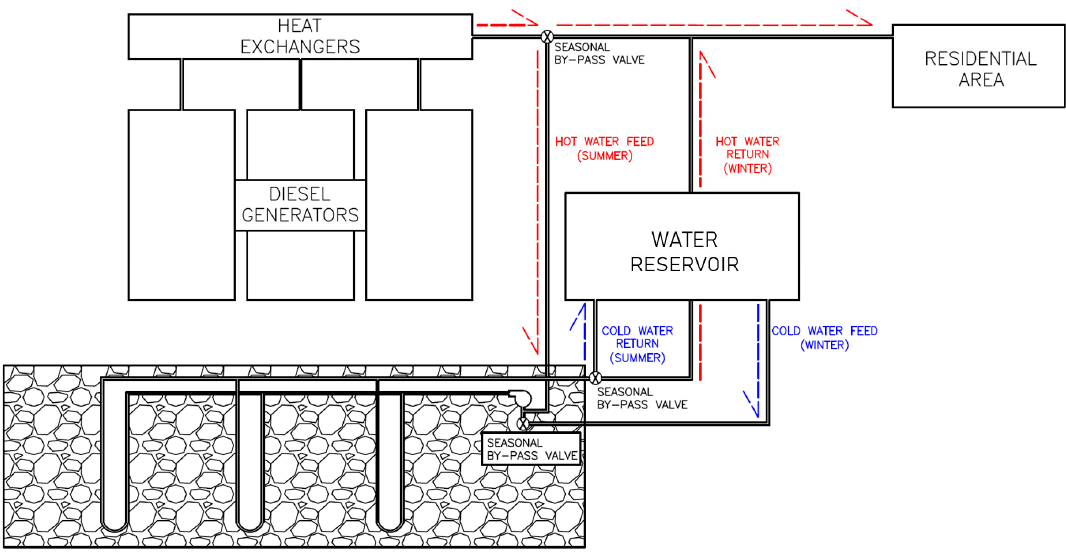
Figure 1. Schematics of heat recovery, storage, and extraction by use of BTES (not to scale). Note that, BTES systems are individually represented as hot stream and cold stream for heat-injection and heat-extraction cases, respectively.